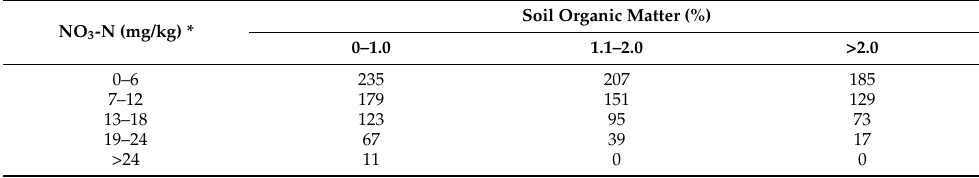
Table 5. Suggested nitrogen rates (kg N ha − 1 ) for irrigated maize, as related to NO 3 -N in the soil and soil organic matter content, calculated from the algorithm. Target yield for this algorithm is 11 Mg grain per ha, and recommended N rate does not account for other N credits. Adapted from Davis and Westfall (2014) [48].